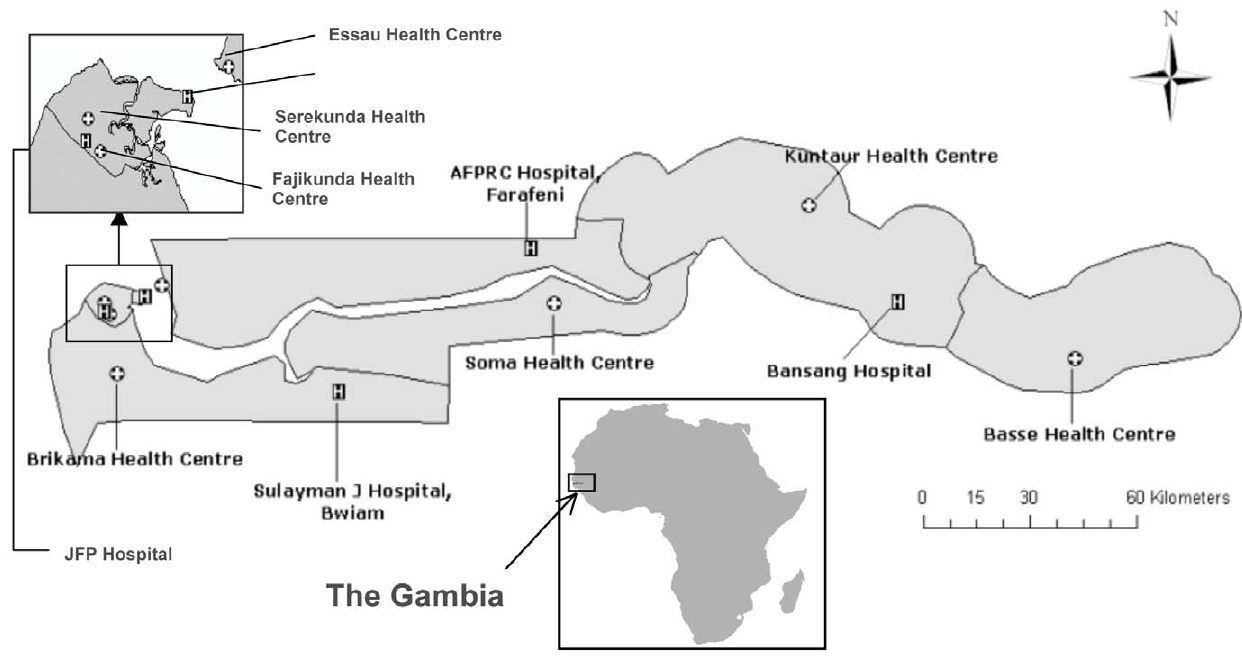
Figure 1. Map of The Gambia, showing hospitals and major health centres and the coastal region in which the study was conducted.